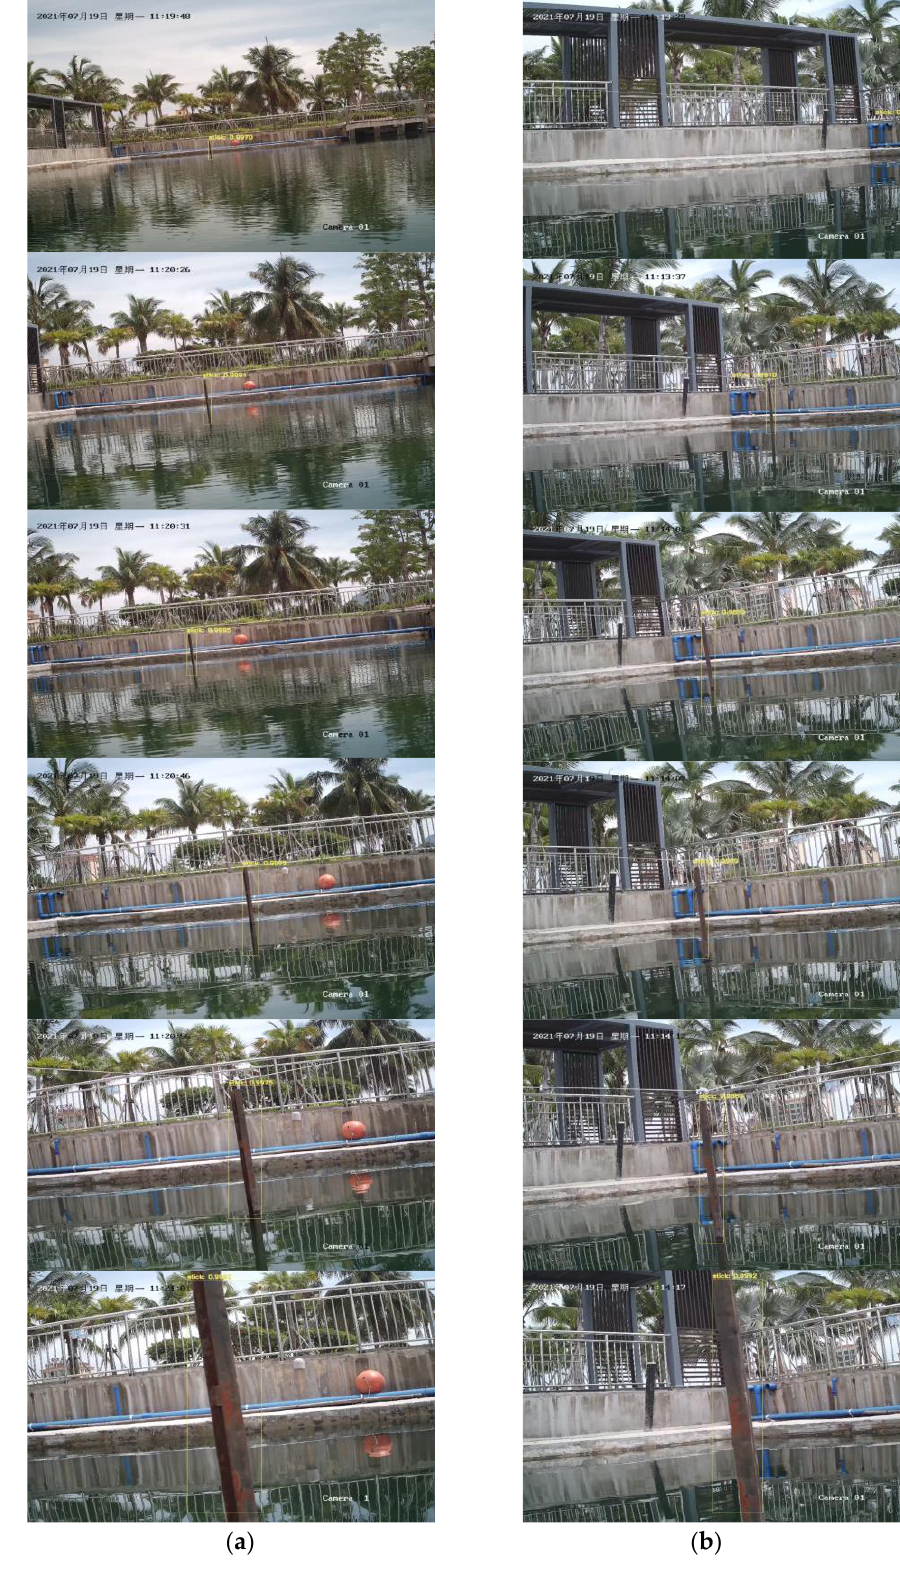
Figure 16. Different views during movementprocess of ASV: ( a ) forwardexperiment, ( b ) left and forwardexperiments.